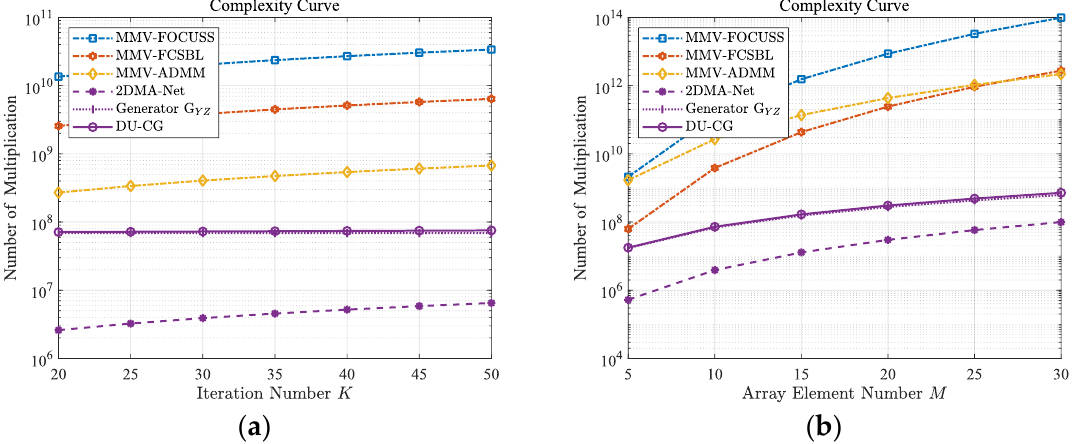
Figure 15. Computational complexities of different algorithms under different conditions: ( a ) the computational complexity varies with the iteration number and ( b ) the computational complexity varies with the array element number.